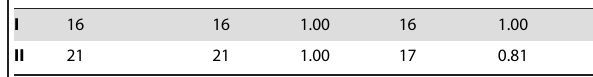
Table 4. Stability of the prediction motifs.